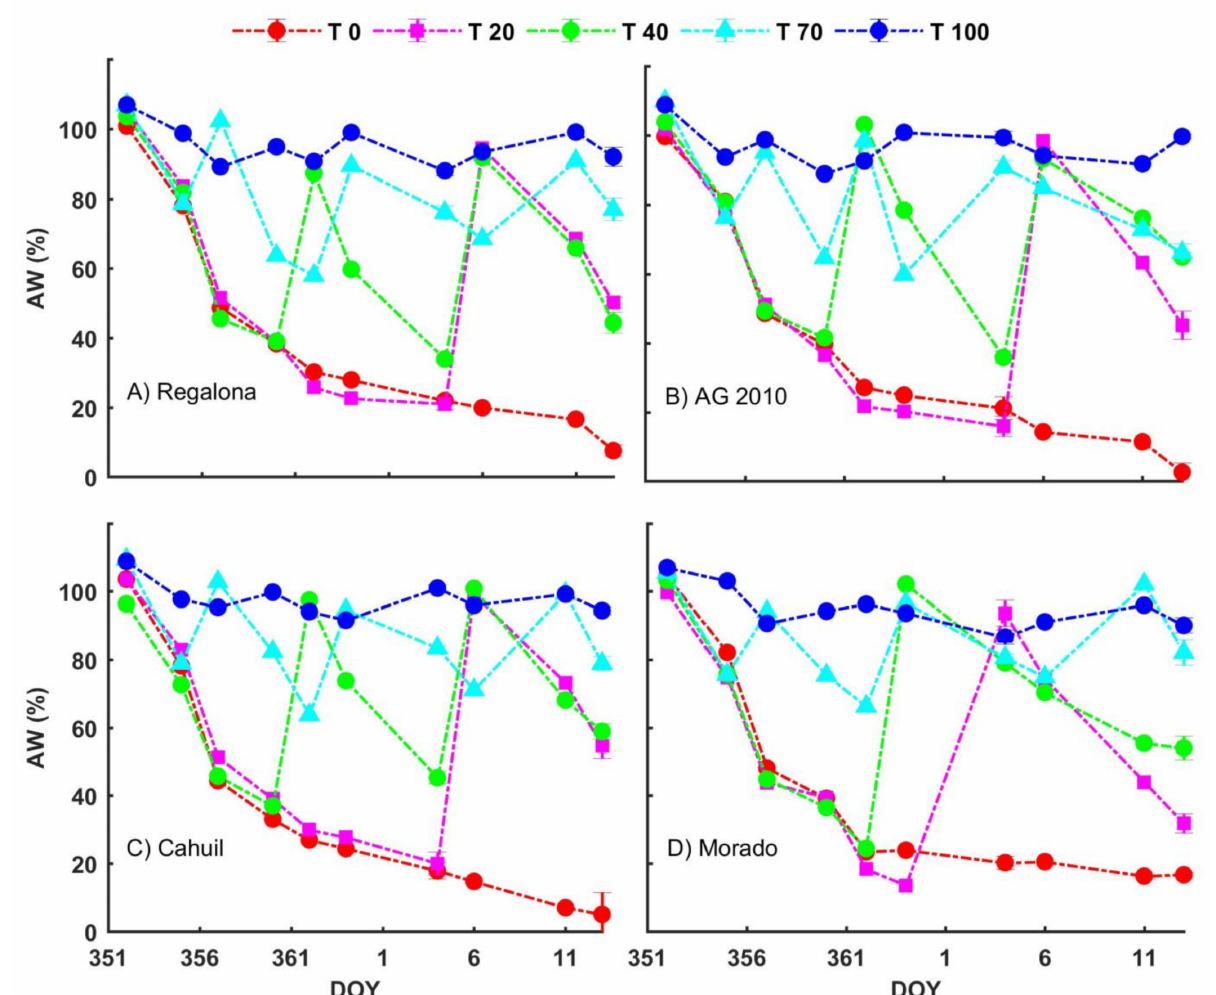
Figure 3. Evolution of available water (AW) in five irrigation treatments (T): T0, T20, T40, T70, and T100, and four quinoa genotypes: ( A ) Regalona, ( B ) AG 2010, ( C ) Cahuil, and ( D ) Morado, between the beginning of grain filling throughout the physiological maturity stages, in the 2015/2016 season. AW and 0, 20, 40, 70, and 100 represent the levels of available water to the plant in a 0.6 m deep root zone just before irrigation. DOY is the day of year. Bars indicate ± one standard